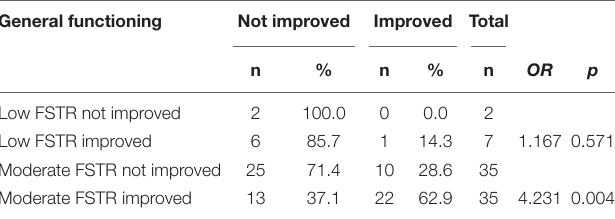
TABLE 2 | Comparison of number and percentage of not improved and improved participants between first- and last session scores on general functioning (C-ORS) and quality of the FSTR (C-SRS).